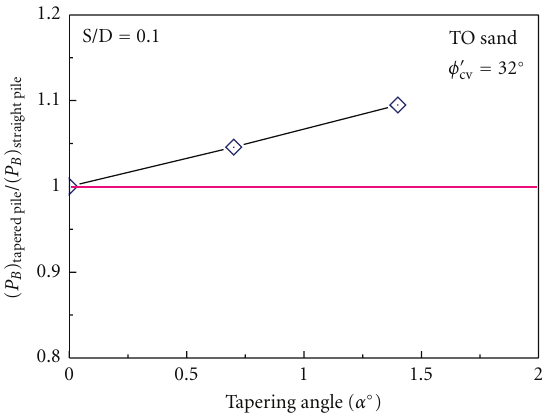
Figure 8: Normalized end-bearing capacity of TO sand at di ff erent pile tapering angles.